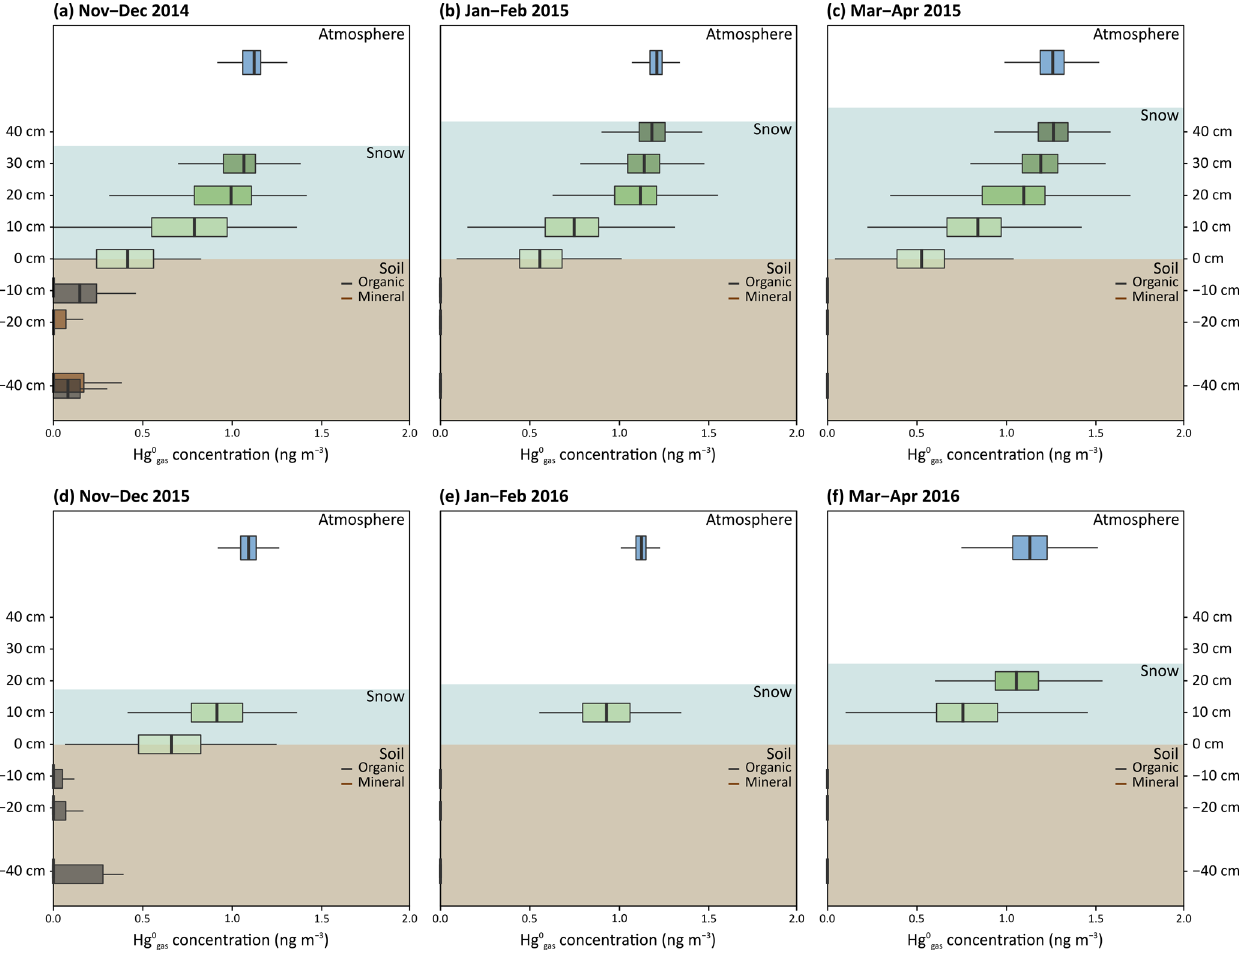
Figure 4. Hg 0 gas concentration profiles in the atmosphere, snowpack interstitial air, and soil interstitial air in early winter (from November to December; a and d ), in winter (from January to February; b and e ), and in early spring (from March to April; c and f ) for 2014–2015 (a–c) and 2015–2016 (d–f) snow-covered periods over the Arctic tundra measured at Toolik Field